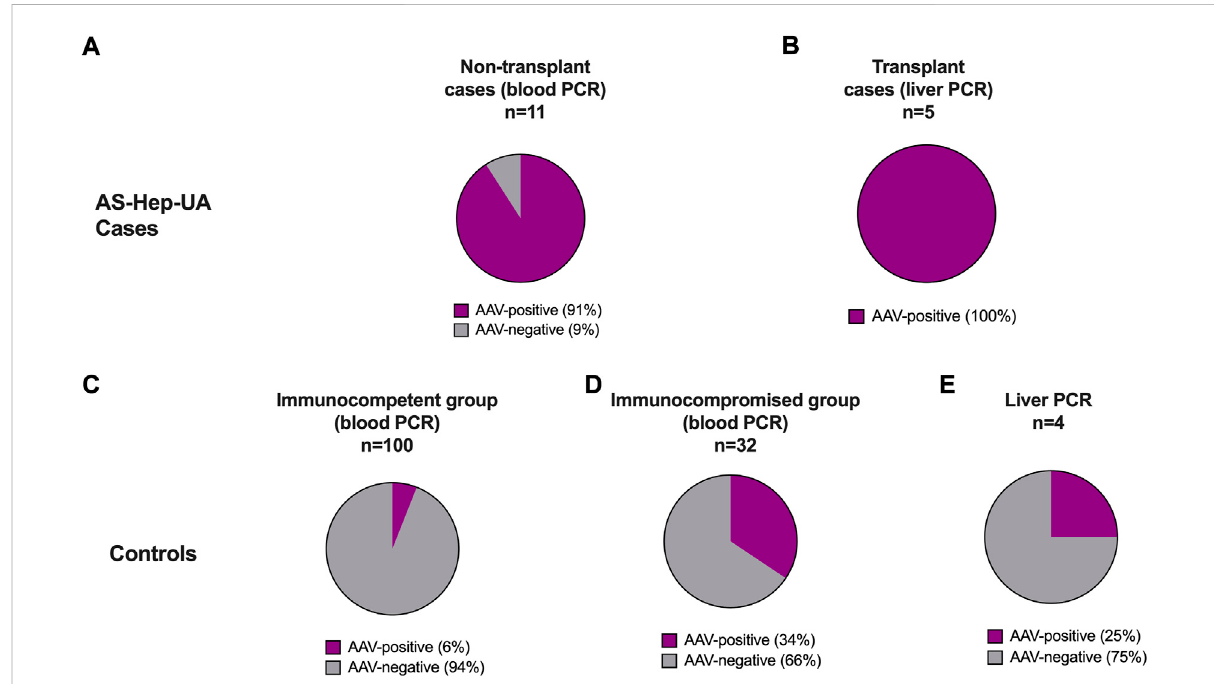
FIGURE 6 RateofpositivityforAAVamongsamplestestedintheUnitedKingdomtorepresentAS-Hep-UAcasesandasetofpaediatriccontrolsamples.In each case, purple represents samples testing AAV-positive by PCR, with grey showing AAV-negative cases, demonstrating a signi fi cant excess of AAV-positives in AS-Hep-UA cases (A,B) comparedto samples collectedfrom children incontrol groups (C – E) . Data are collated from thereport by Morfopoulou et al.